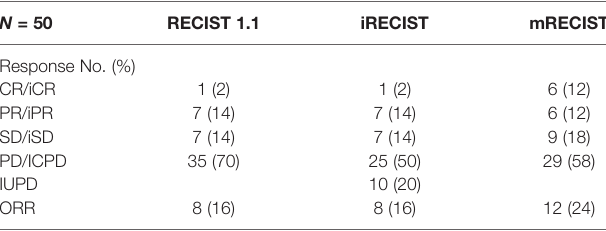
TABLE 2 | Treatment outcomes per RECIST 1.1, iRECIST, and mRECIST.